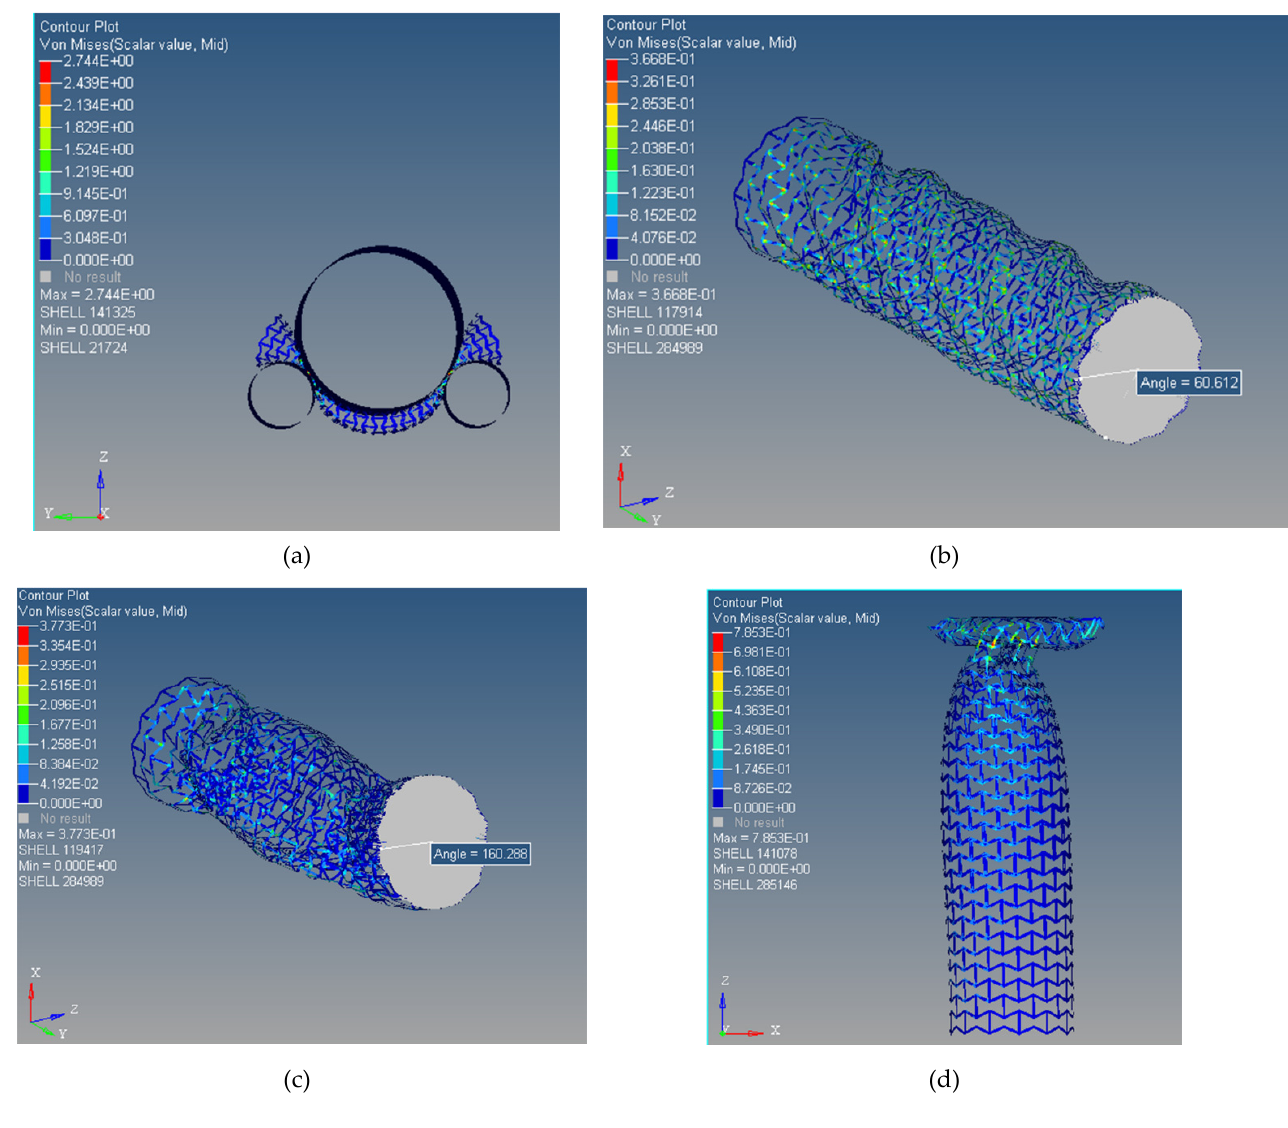
Figure 5. Von-Misses stress distributions for stents at failure stage based on finite element analysis: ( a ) three-point bending; ( b ) 60° angle of twist; ( c ) 160° angle of twist; and ( d ) longitudinal compression.